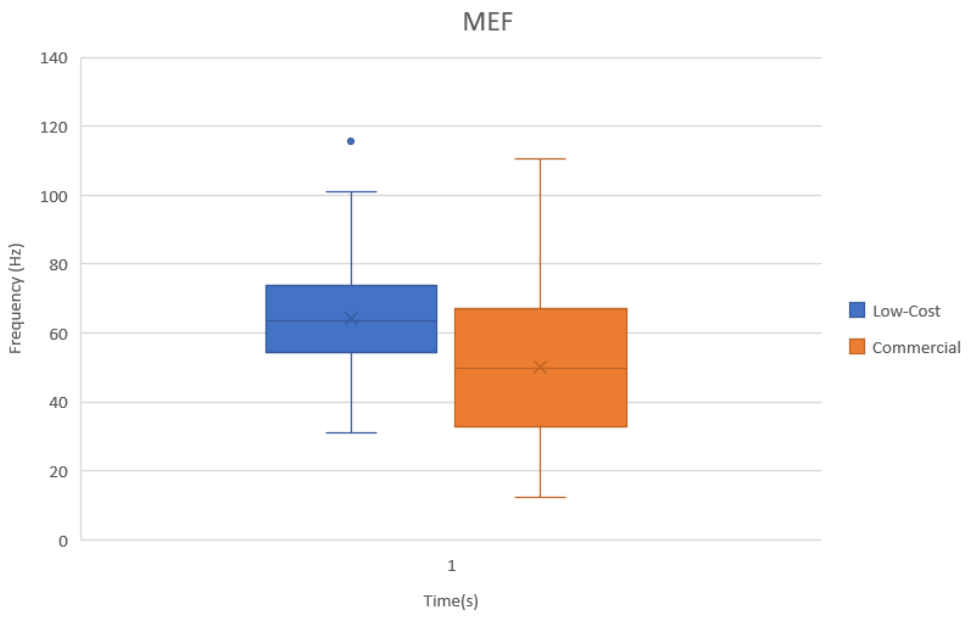
Figure 13. MEF of the